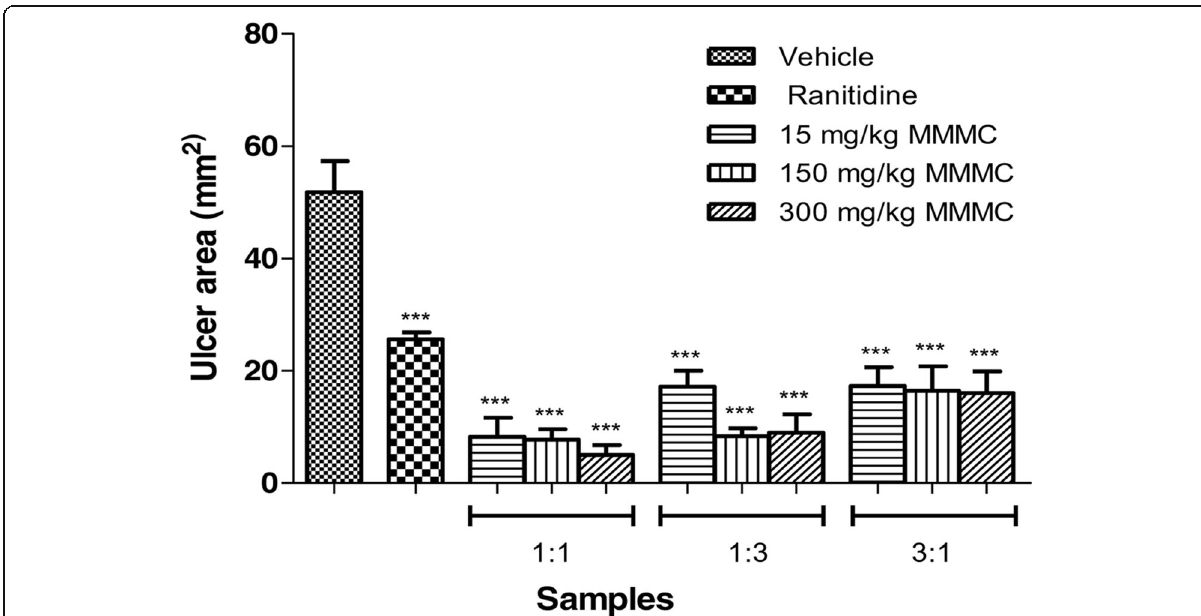
Fig. 3 Effect of orally administered vehicle (Tween 80, 2%), ranitidine (100 mg/kg) or different ratio of 15, 150 and 300 mg/kg MMMC on ulcer area formation in the ethanol-induced gastric ulcer model. The ulcerated area (mm 2 ) was expressed as Mean ± SEM for six animals. One way ANOVA was followed by Dunnett ’ s post-hoc test, *** p < 0.001 vs